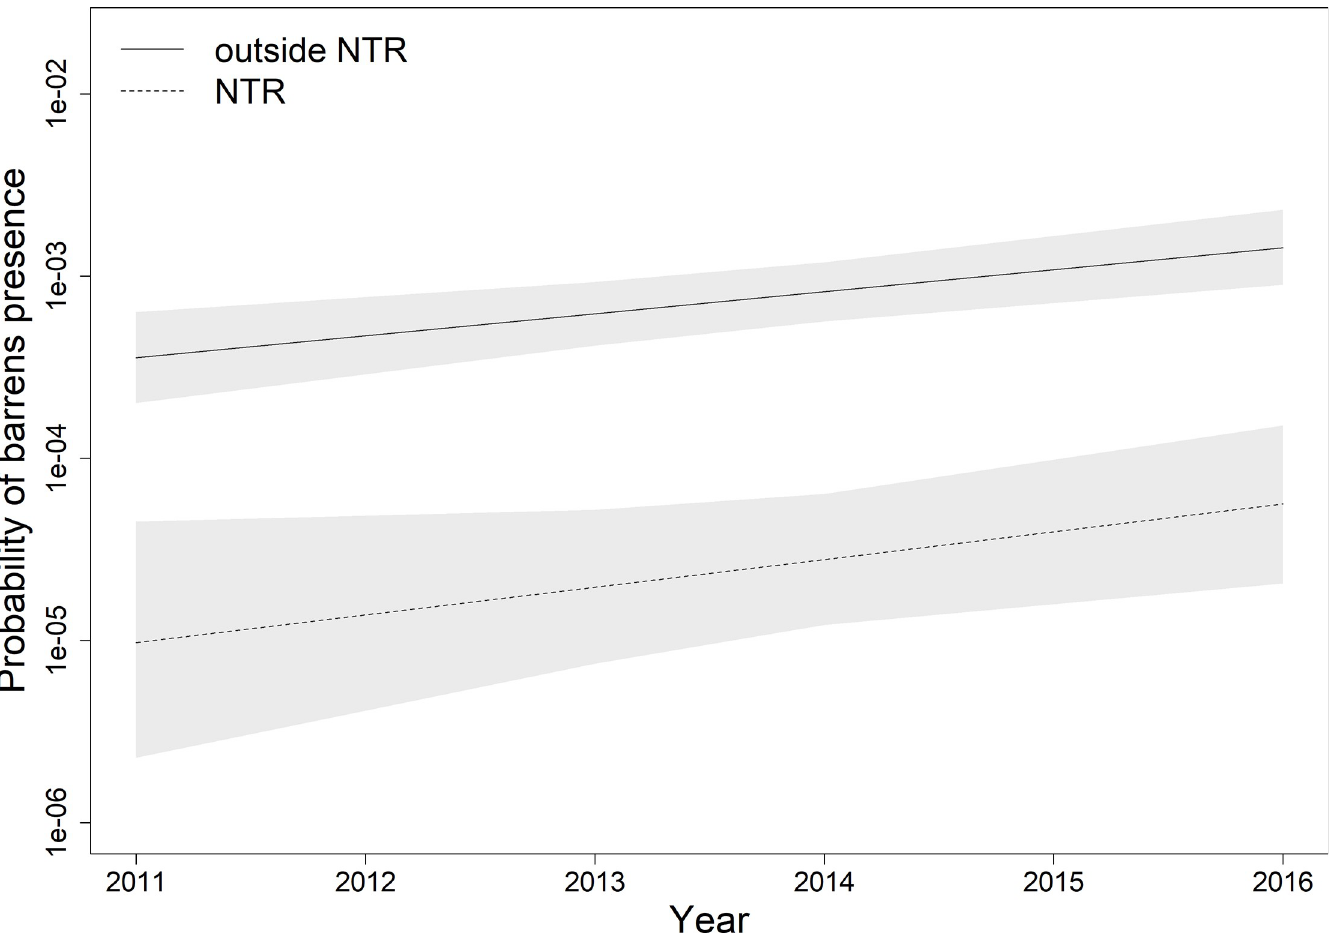
Fig 3. Conditional relationships for probability of barrens presence over the survey period for sites inside and outside the No-Take Reserve (NTR). Probabilities were calculated by taking 5000 posterior draws from the fitted spatio-temporal model (model M 3 ) and conditioned on the mean values for depth and rugosity from inside and outside the NTR. Predictions were conditioned on spatio-temporal random effects set equal to zero. Lines are posterior means and shaded areas 95% credible intervals. Note logarithmic y-axis.